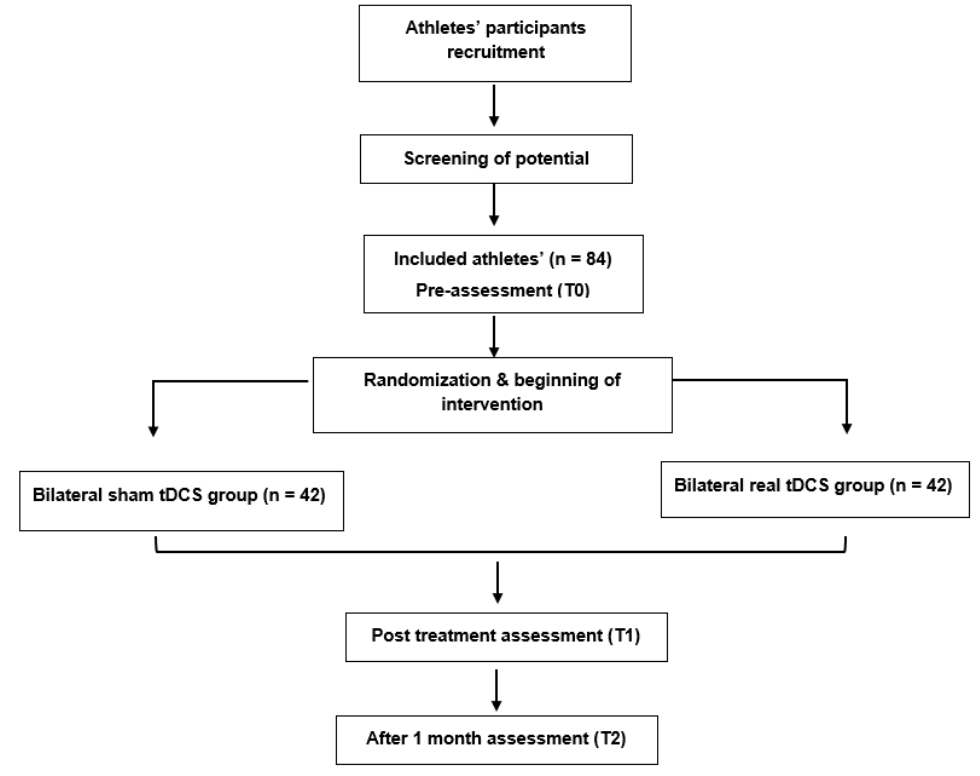
Figure 1. The CONSORT flow diagram of the study procedures. CONSORT = Consolidated Standards of Reporting Trials, tDCS = transcranial direct current stimulation.